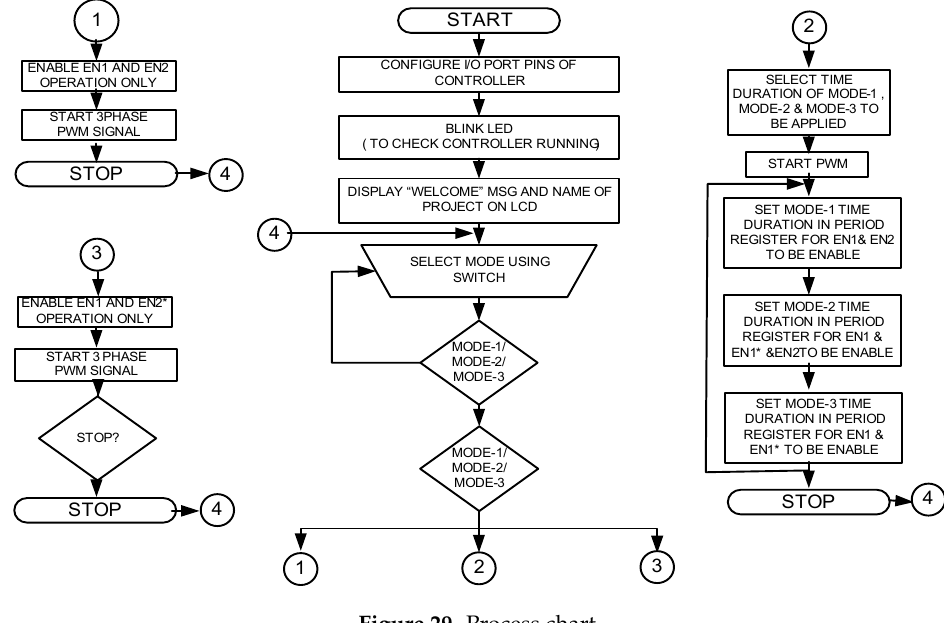
Figure 29. Process chart.